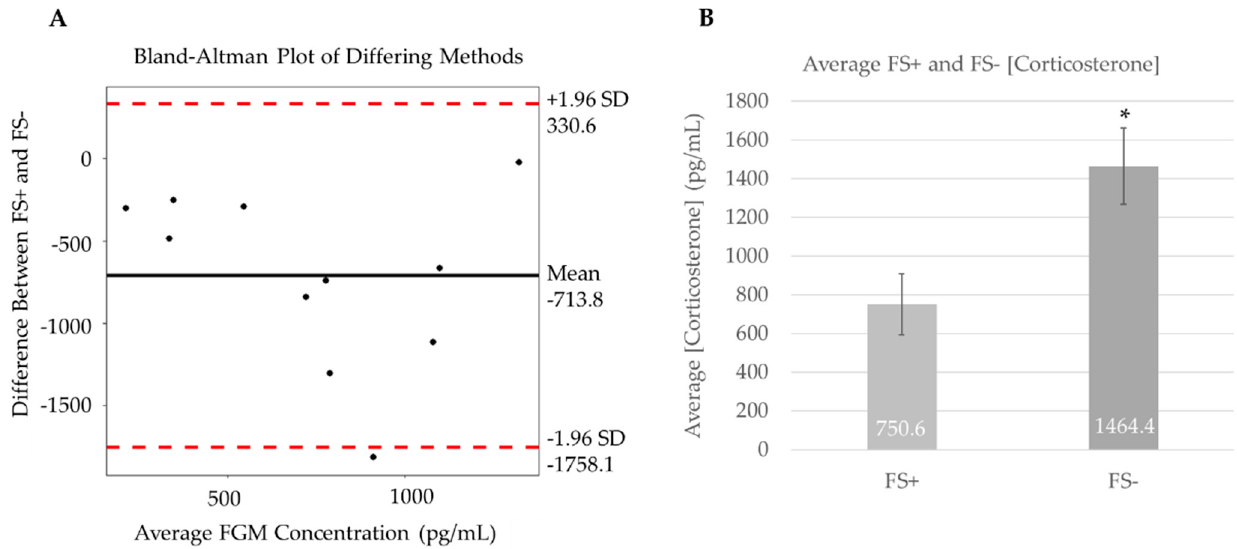
Figure 2. Difference in extraction methods for measuring corticosterone from fecal samples of Pituophis species. ( A ) Bland–Altman plot displays the difference in measured corticosterone (N = 11) comparing yield from different fecal sample extraction methods: one from undigested materials (FS+) and the other with undigested materials removed (FS − ). ( B ) Bar graph (error bars represent SEM) emphasizing the 95% increase in overall yield of corticosterone measured from FS − compared to FS+ (* p < 0.01).